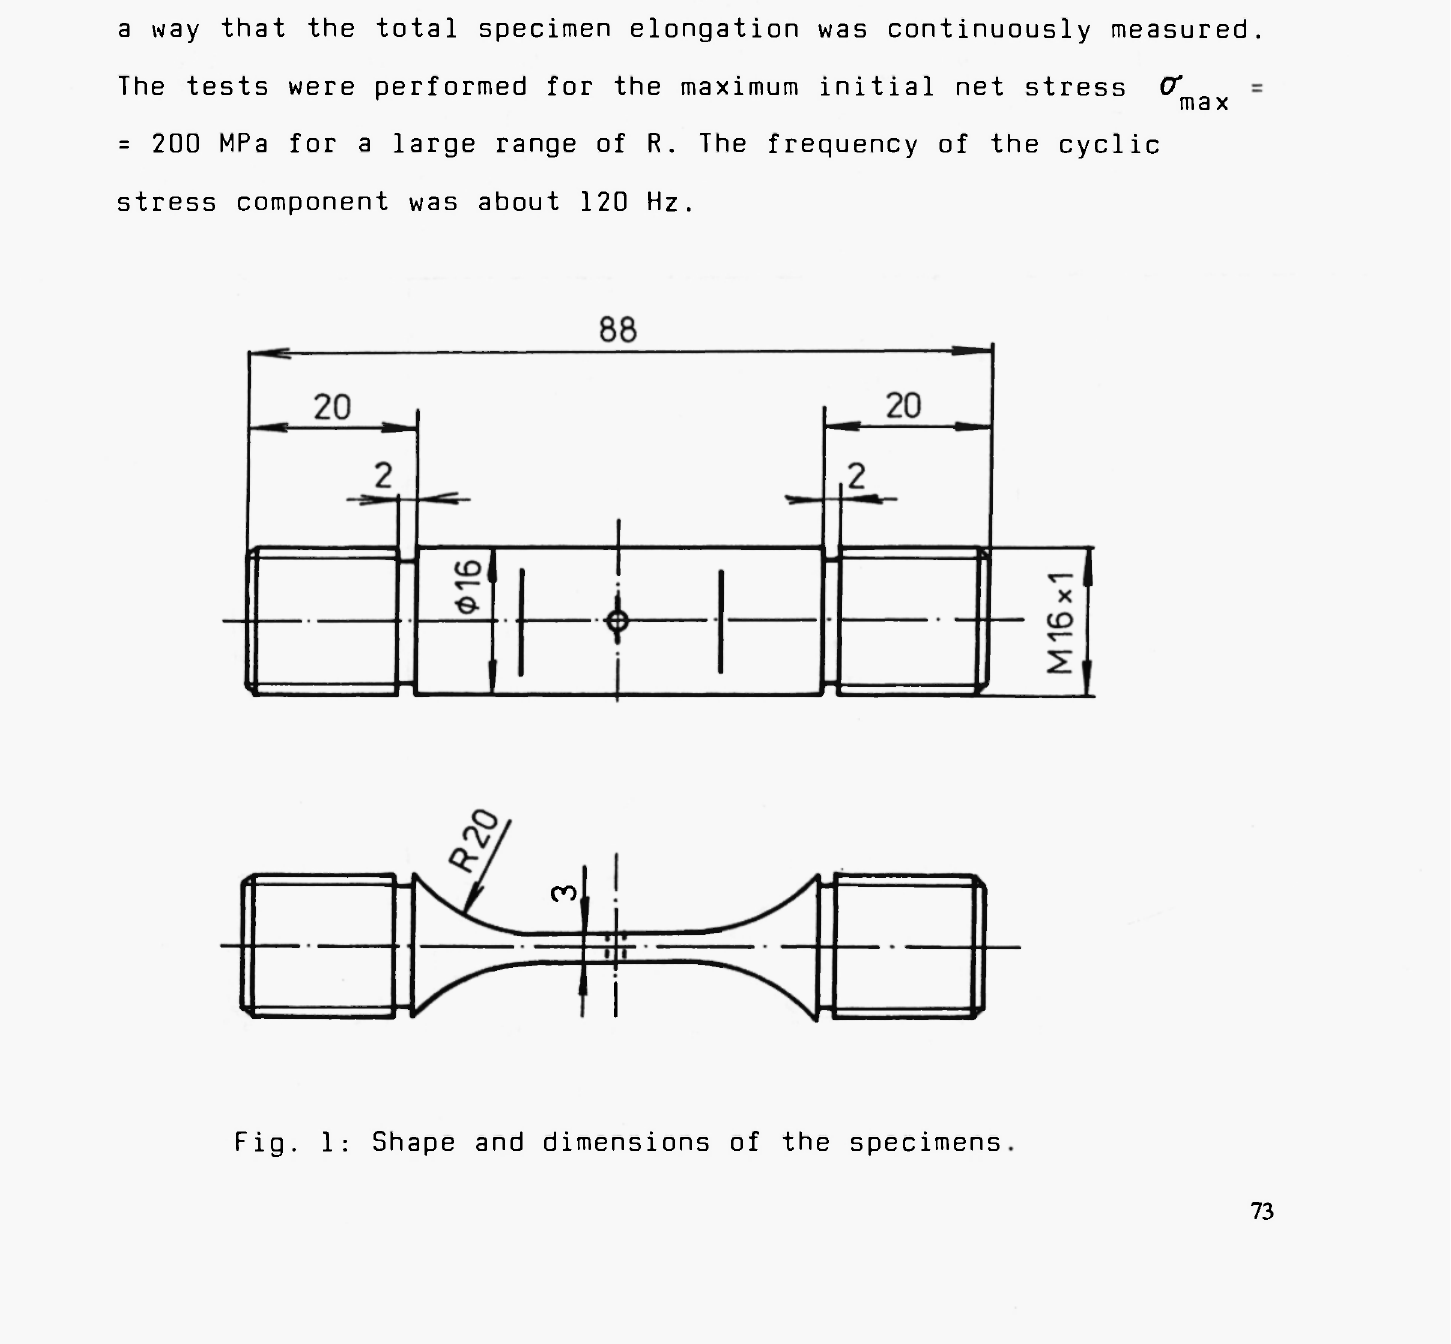
Fig. 1: Shape and dimensions of the